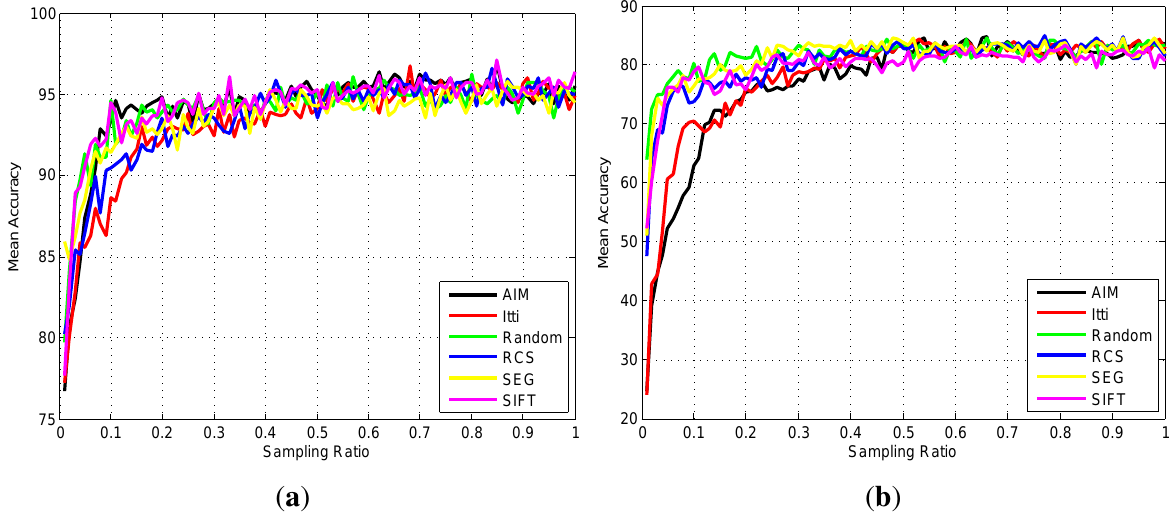
Figure 13. Comparisons of the classification accuracy using different sampling methods on the scenes of agricultural ( a ) and meadow ( b